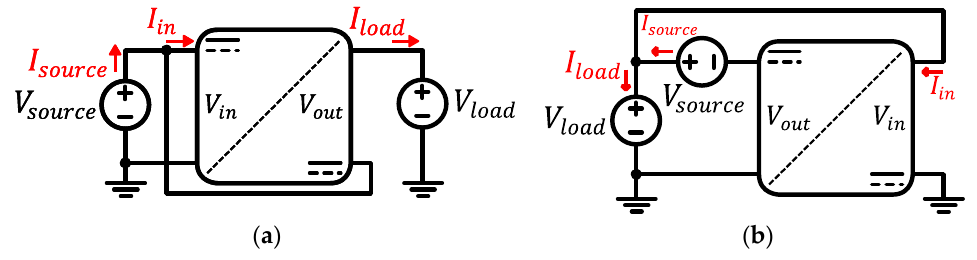
Figure 2. PPC architectures. ( a ) IPOS. ( b ) FC.